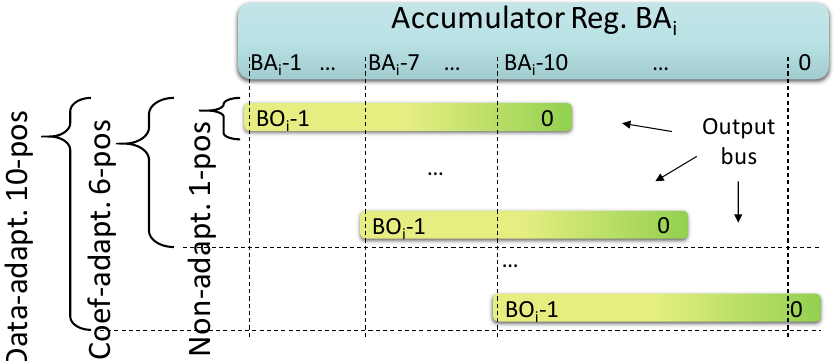
Figure 7. Barrel-shifter positions for the three different dynamics management strategies. The accumulator of the cell C i features BA i bits numbered from BA i − 1 to 0. The output bus features BO i bits numbered from BO i − 1 to 0. The shifter has 1, 6, 10 positions for non-, coeff-, data- adaptive strategies, respectively.